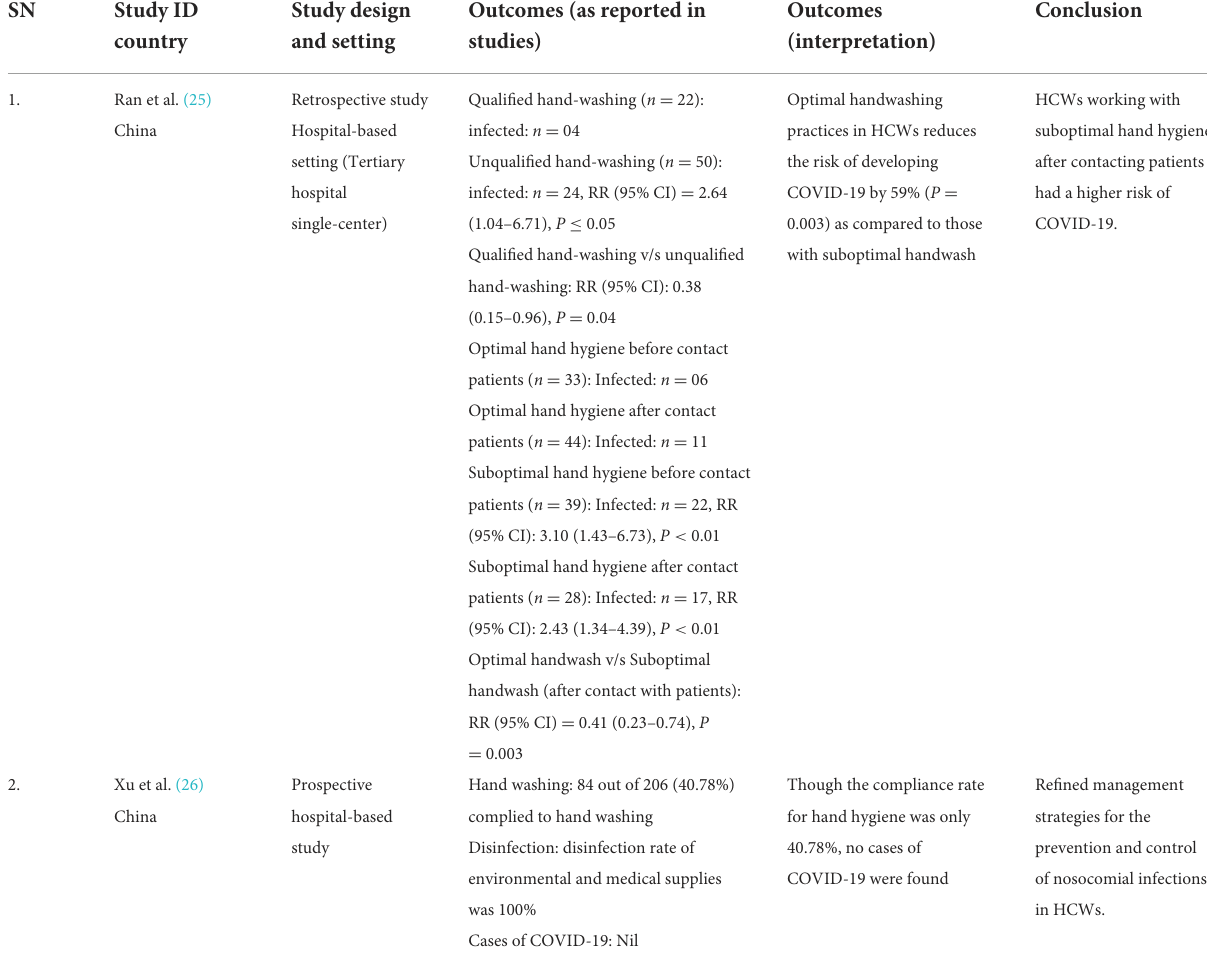
TABLE 3 Results of included studies table (Direct evidences on COVID-19 for primary outcome of Incident